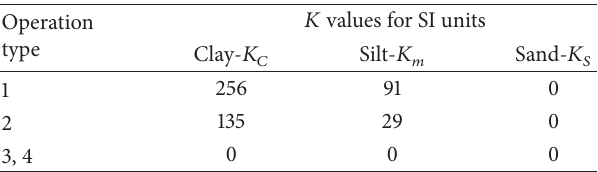
Table 4: 𝐾 values for incoming sediments based on reservoir operation and type of sediment